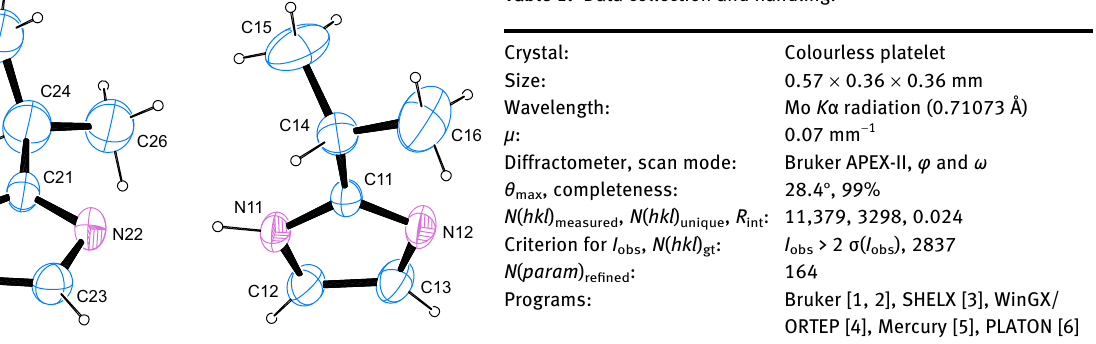
Table  : Data collection and